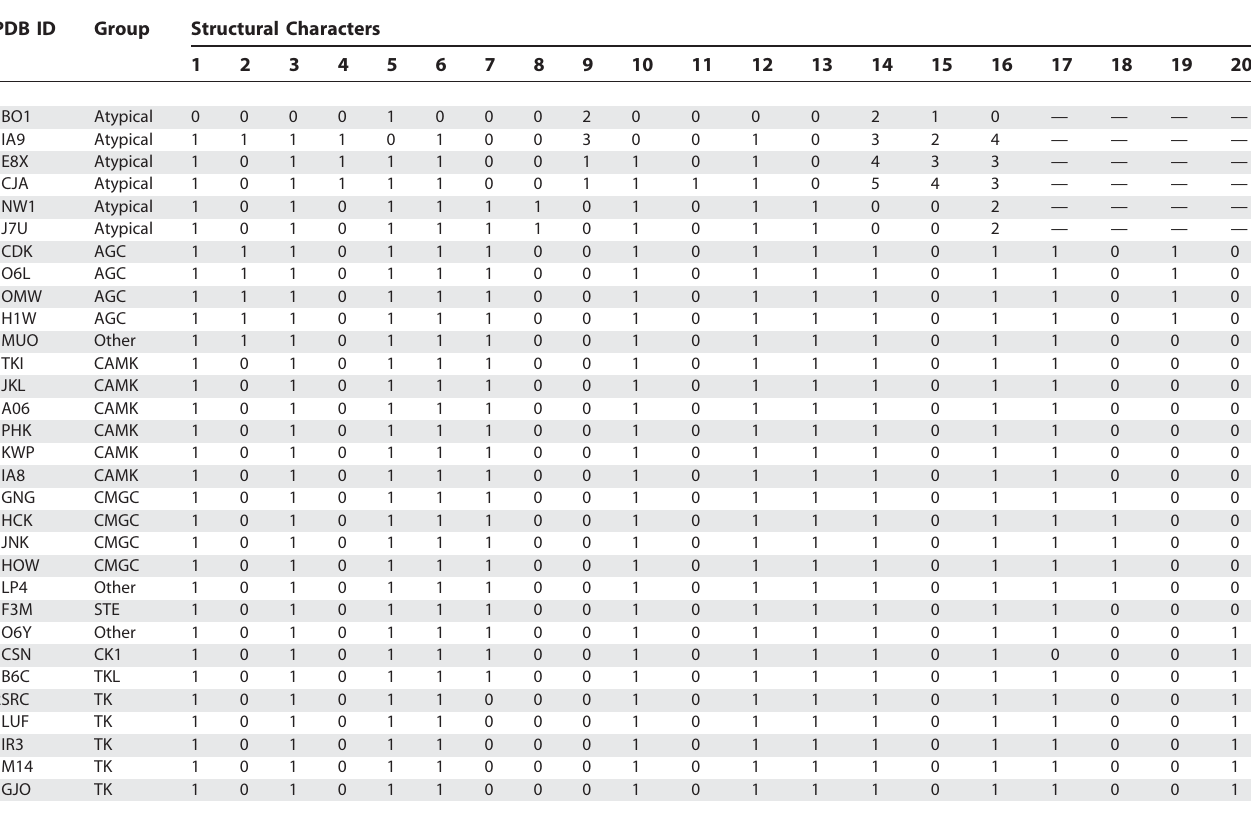
Table 2. Distinctive Structural Characters Used in the Construction of a Phylogeny for the Kinases PDB ID